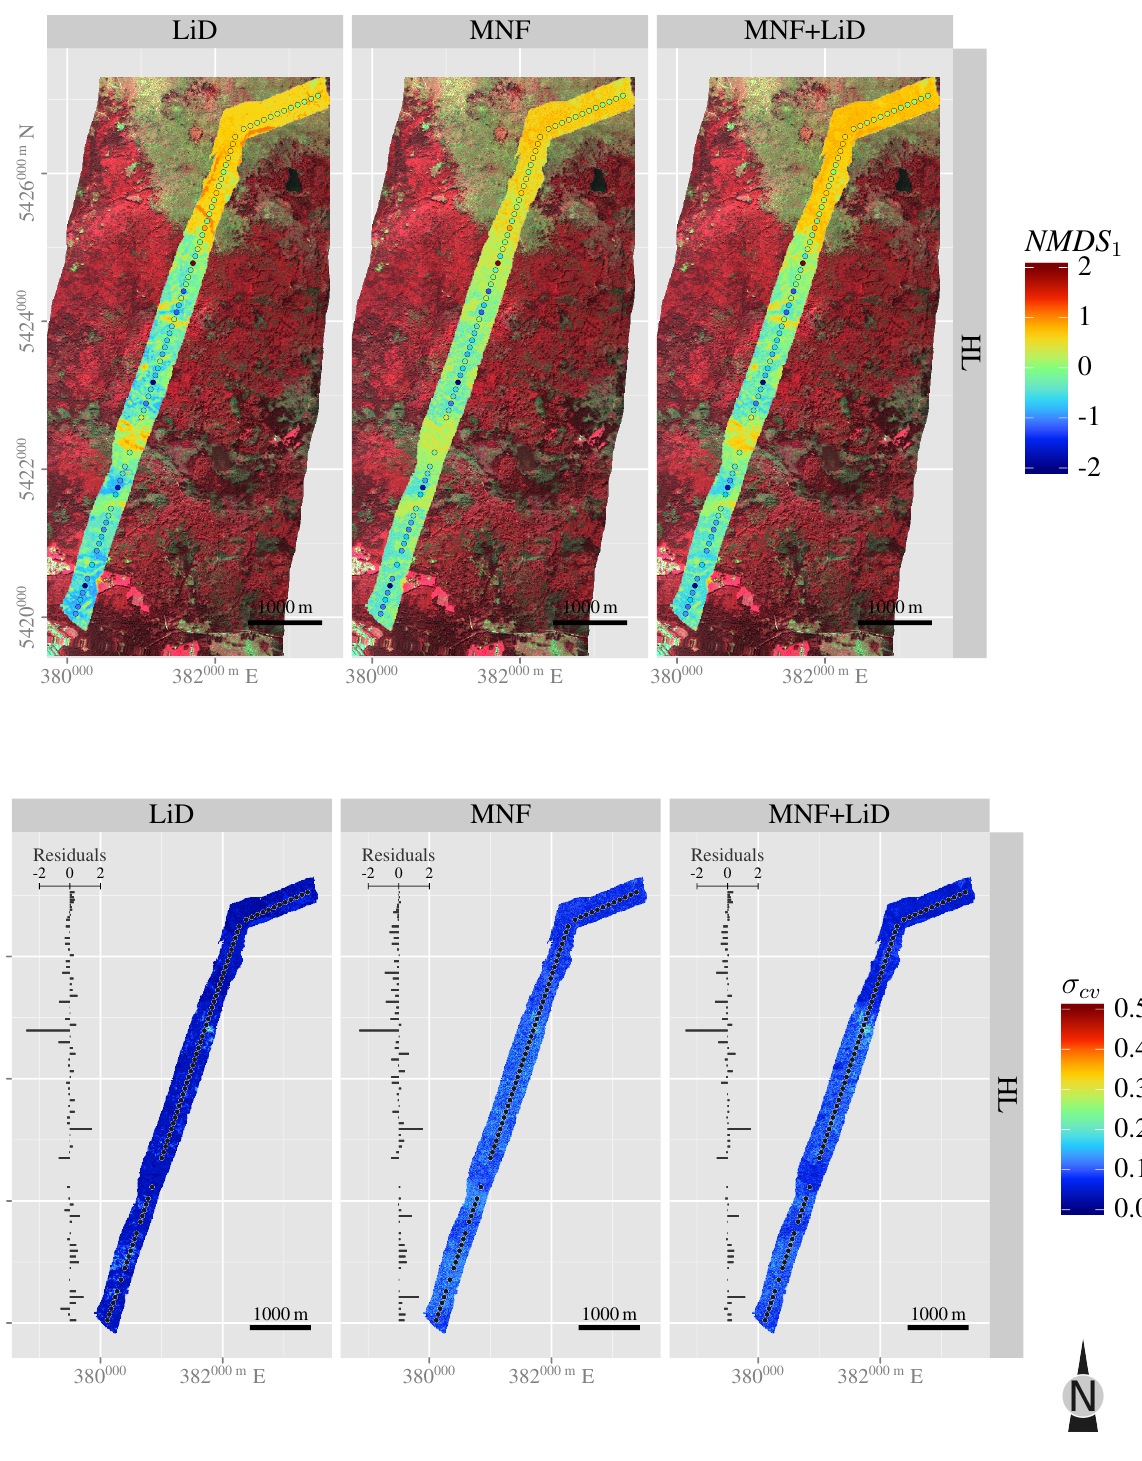
Figure 8. Spatial prediction of position on the first NMDS axis of the herb layer (HL) for the LiDAR (LiD) and hyperspectral (MNF) predictor sets and their combination (MNF+LiD). Upper panel: averaged predictions of ten cross-validation models and plot information used to train and evaluate the random forests. Background: CIR composite of the HyMap data. Lower panel: standard deviation of the predictions of the ten cross-validation models. Bar charts show the residuals between predicted and observed estimates in cross-validation. Pos- itive residuals are due to an overestimation by the model and vice